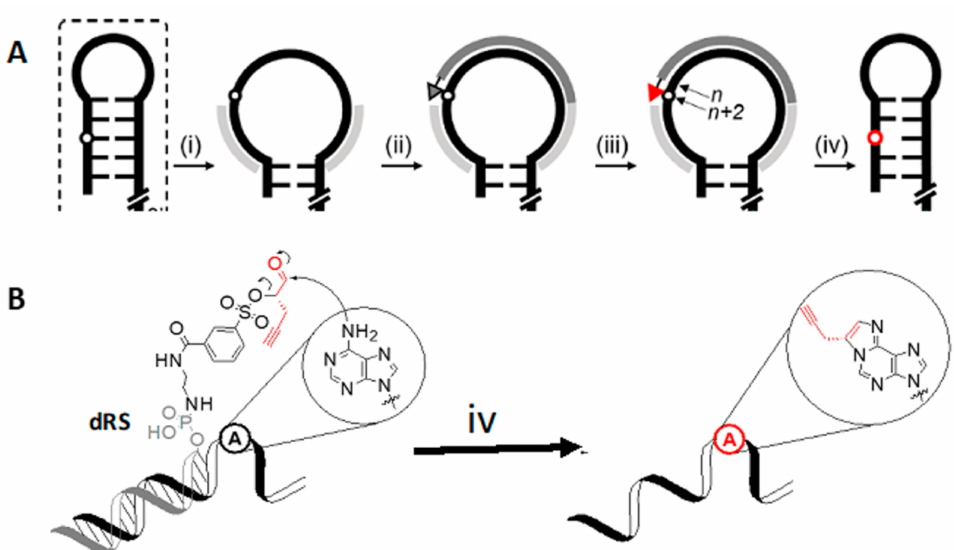
Figure 6. ( A ). (i) DNA Helper Sequences (light gray) annealing, (ii) hybridization of DNA Reactive Sequence (dRS, dark grey) precursor, (iii) activation by sodium periodate, (iv) transfer of the reactive group and modification of an internal adenine. ( B ). Mechanism of reactive group transfer. Adapted with permission from Reference